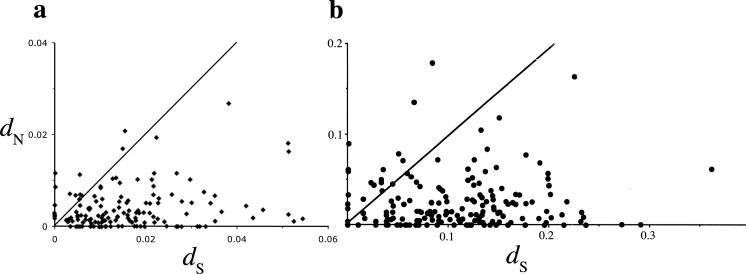
Plots of d
N Versus d
S for Primate and Drosophila Seminal Fluid Genes(A) Genes encoding seminal fluid proteins identified by mass spectrometry in human versus chimpanzee.(B) Drosophila simulans male-specific accessory gland genes versus D. melanogaster [2].The diagonal represents neutral evolution, a d
N/d
S ratio of one. Most genes are subject to purifying selection and fall below the diagonal, while several genes fall above or near the line suggesting positive selection. Comparison of the two plots shows elevated d
N/d
S ratios in seminal fluid genes of both taxonomic groups.